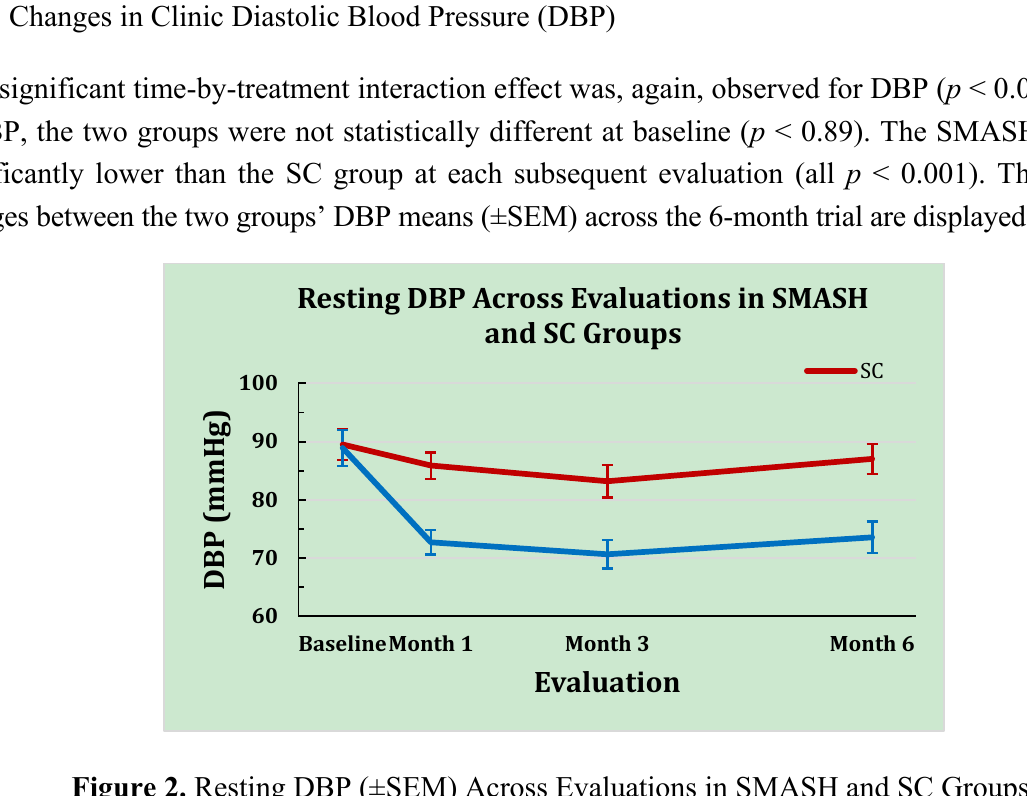
Figure 2. Resting DBP (±SEM) Across Evaluations in SMASH and SC